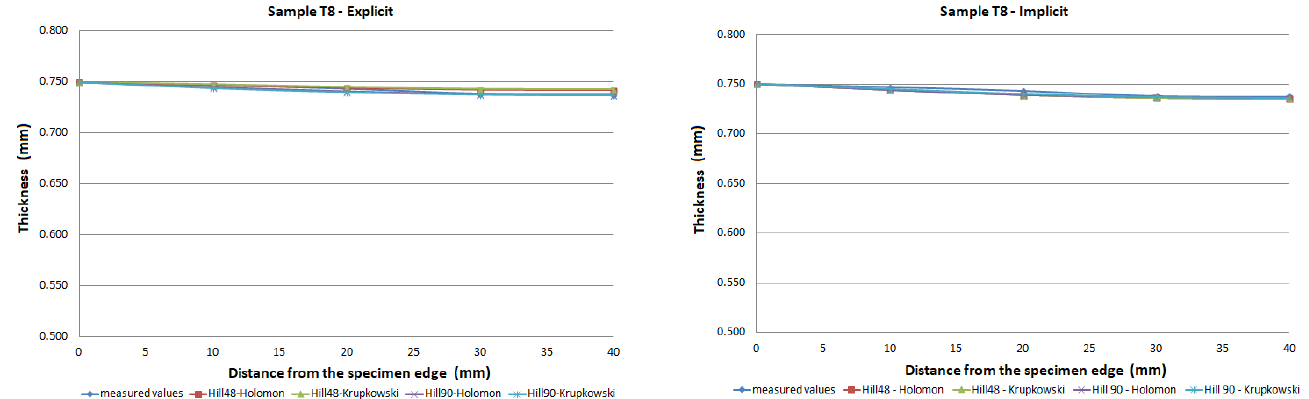
Figure 19. Comparison of predicted and measured thickness values of sample T8 using various yield criteria, hardening laws, and integration scheme.